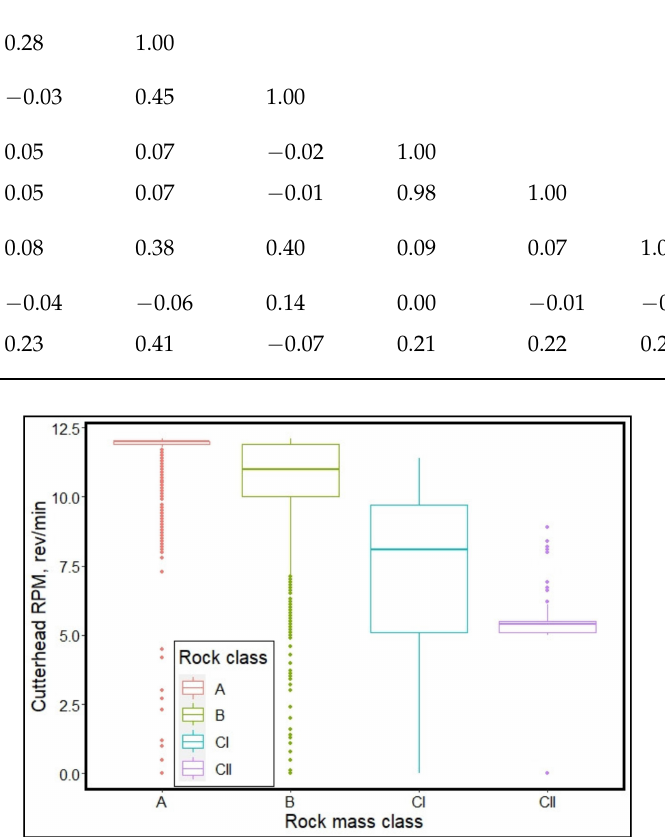
Figure 5. Distribution of cutterhead RPM in different rock mass classes.